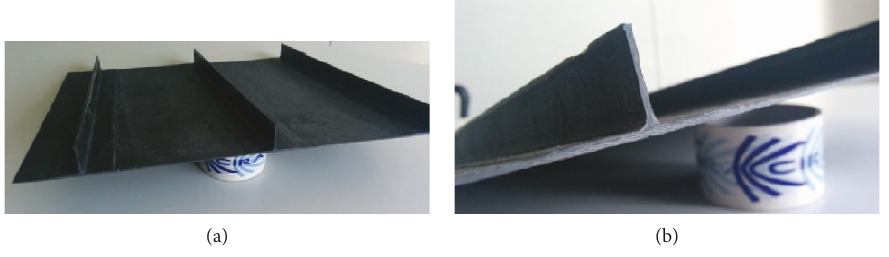
Figure 14: (a) Final panel with 3 co-cured T stringer and (b) T stringer